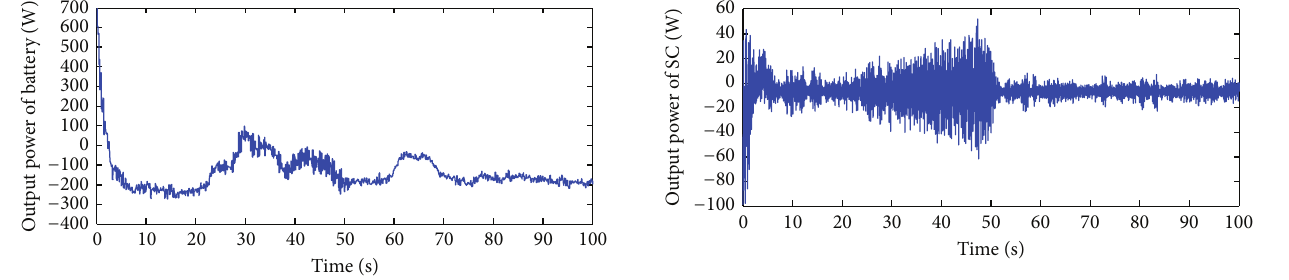
Figure 11: The output power of the lithium ion battery.